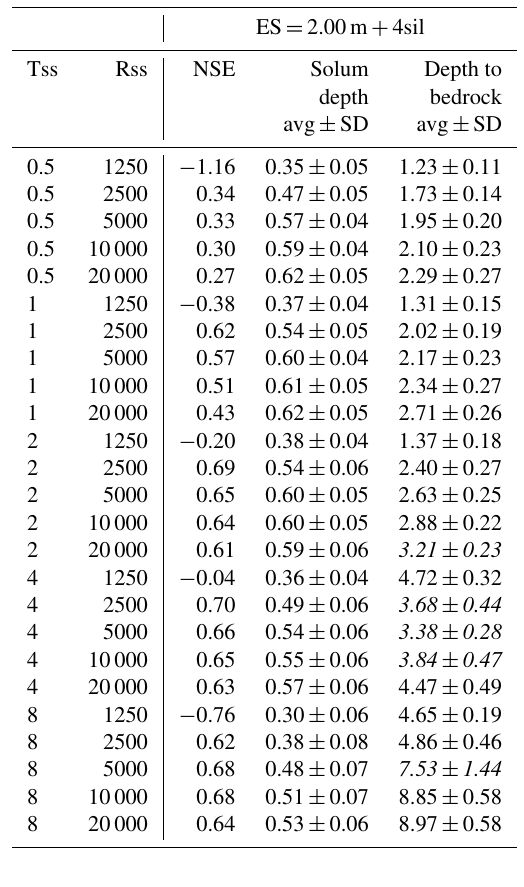
Table 2. Nash–Sutcliffe model efficiency coefficient (NSE) and in- terface depths (avg ± SD, average ± standard deviation in metres; an italic value specifies that the interface delineation results from the merging of several second-derivative zero contours) resulting from the inversion of the 25 synthetic apparent resistivity models (Tss, subsolum thickness in metres; Rss, subsolum resistivity in (cid:127) m) us- ing the Wenner–Schlumberger array with the ES of 2m upgraded with the four interpolated levels of surficial apparent resistivity (sil stands for surficial interpolated